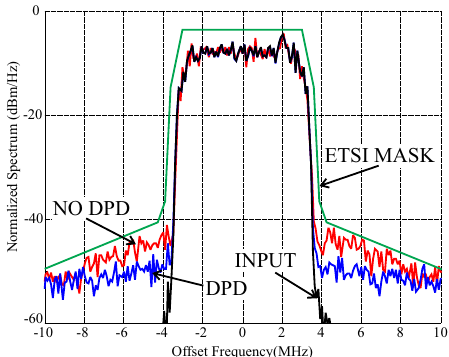
Figure 14. Normalized power spectra from system level measurements on the 15 GHz combined PA. Applied baseband signal: 256-QAM, 7 MHz channel, Peak to Average Power Ratio (PAPR) of 7.4